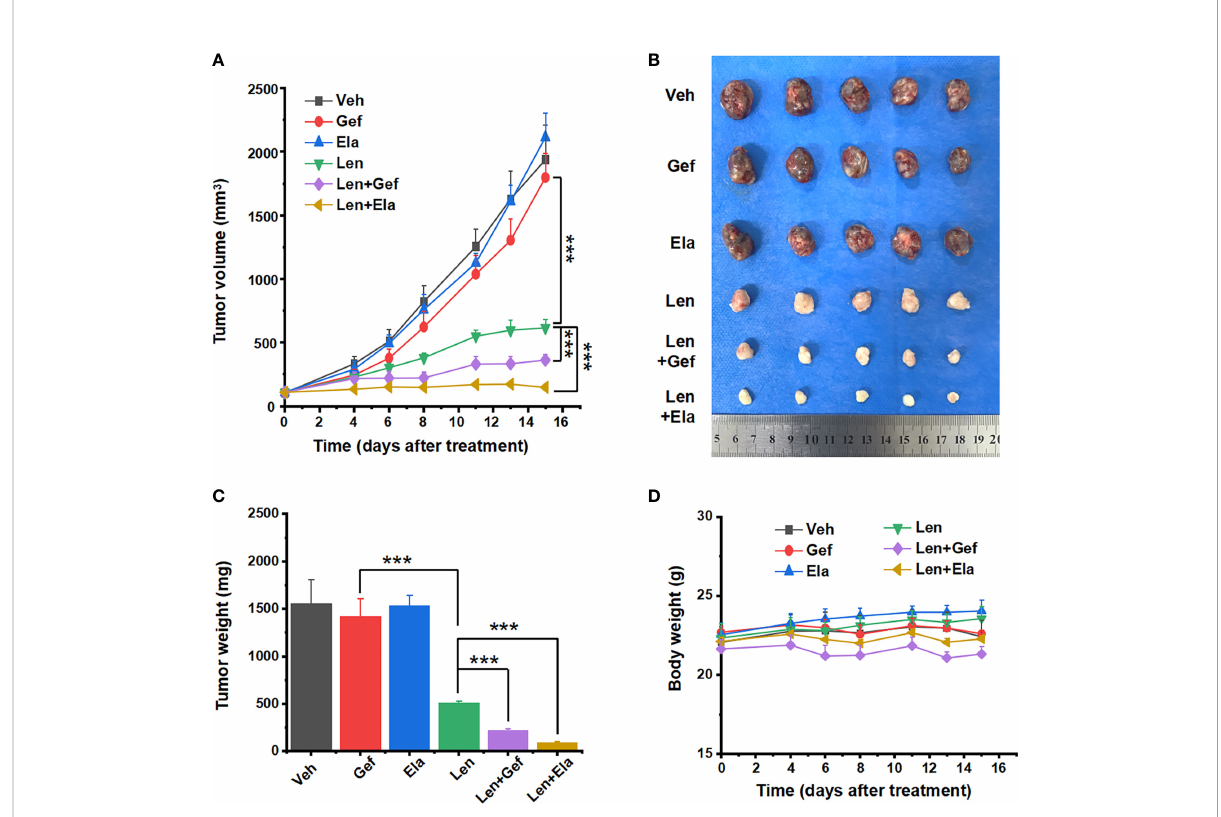
FIGURE 6 Lenvatinib in combination with elacridar or ge fi tinib suppressed HCC xenograft growth. (A) Xenograft response to treatment with vehicle, elacridar (80 mg/kg), ge fi tinib (80 mg/kg), lenvatinib (5 mg/kg), and drug combination (elacridar 80 mg/kg and lenvatinib 5 mg/kg or ge fi tinib 80 mg/kg and lenvatinib 5 mg/kg). (B) Harvested tumours are arranged according to the treatment group. (C) Tumour weights were measured after resection. (D) Mouse body weights were measured during the treatment. *** p <